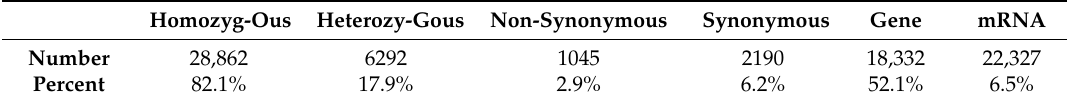
Table 3. SNP distribution in different genomic components.